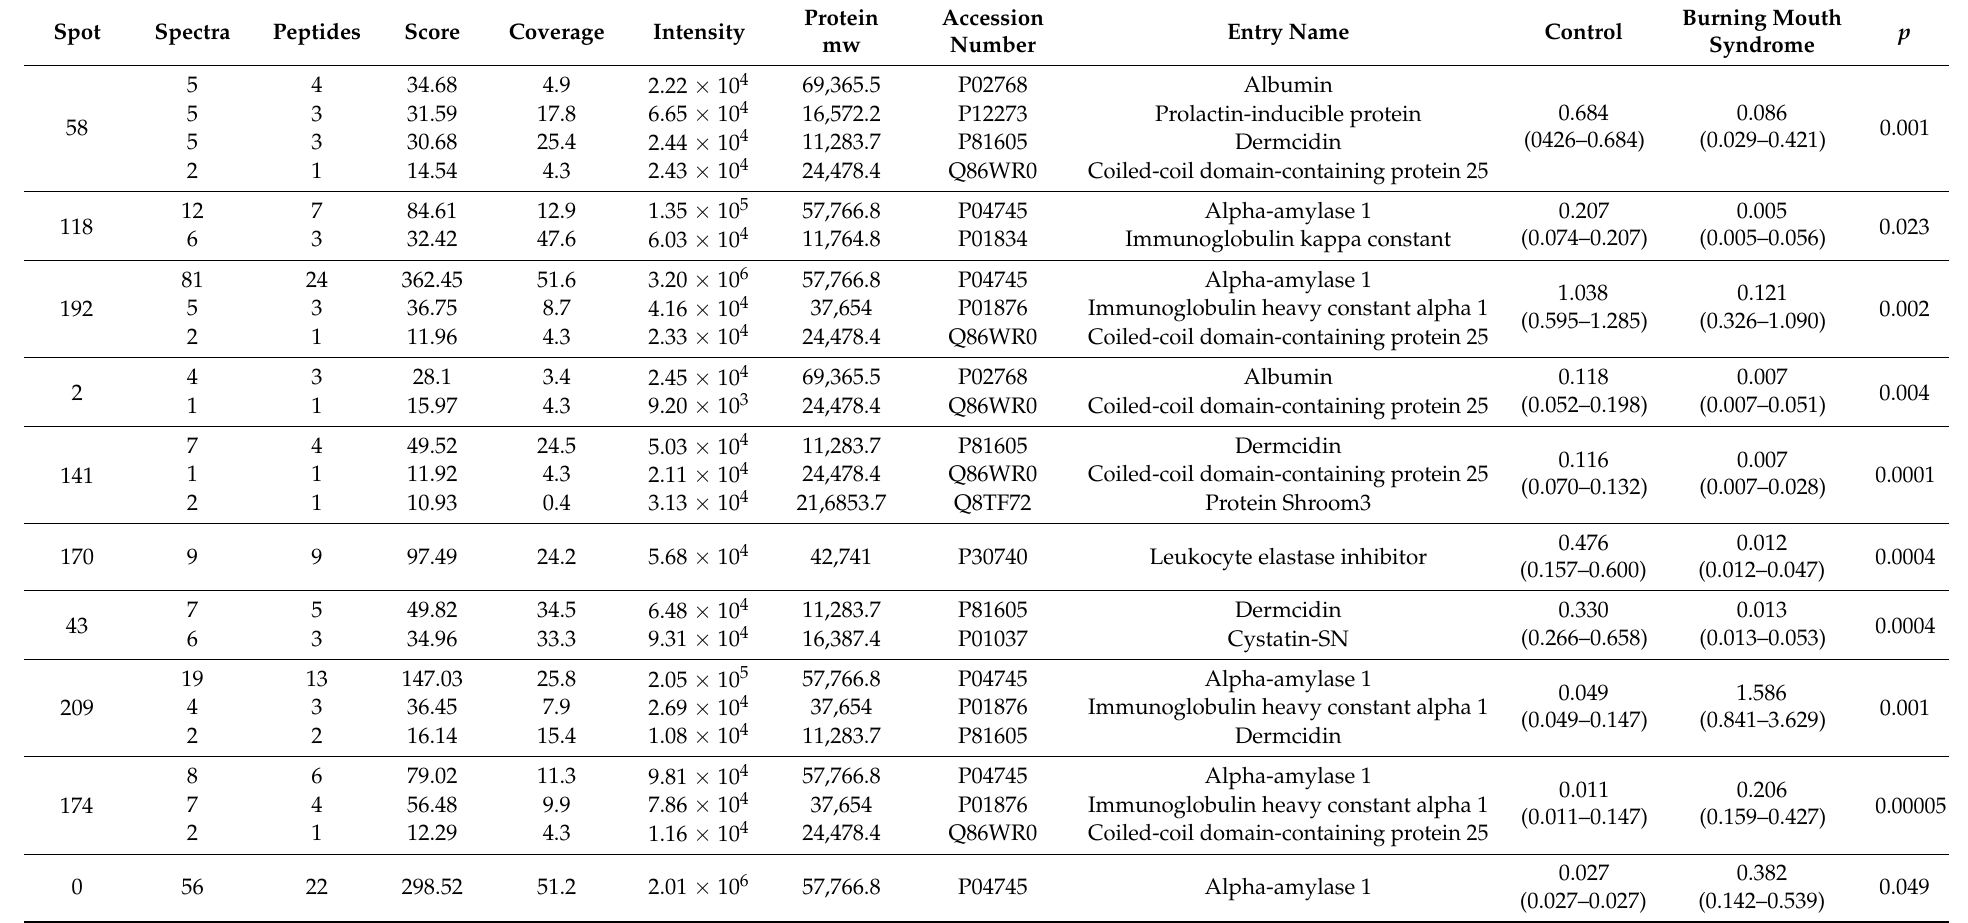
Table 1. Mass spectrometry results on identified spots. Abundances are expressed as median (25–75